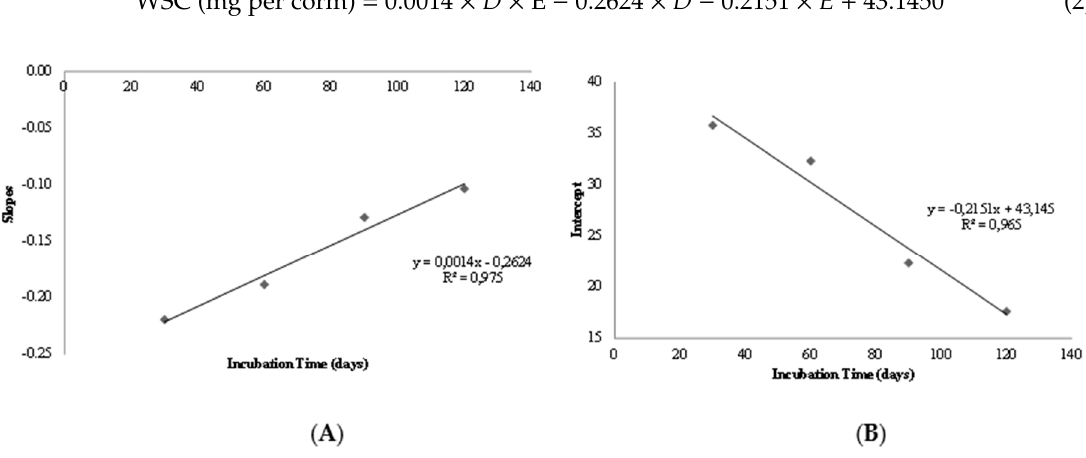
Figure 6. Graph of the slopes ( A ) and intercepts ( B ) obtained for the different incubation times throughout the incubation time.